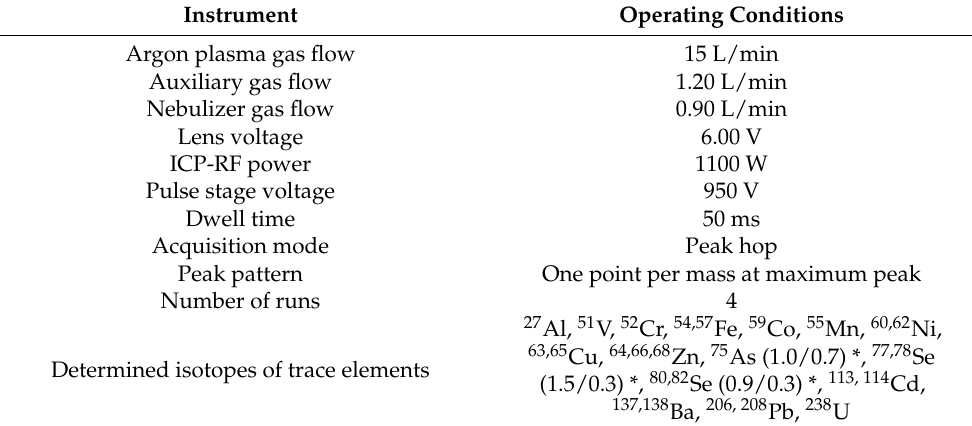
Table 1. Instrumental conditions for ICP-MS measurement (Perkin–Elmer SCIEX DRC-e).